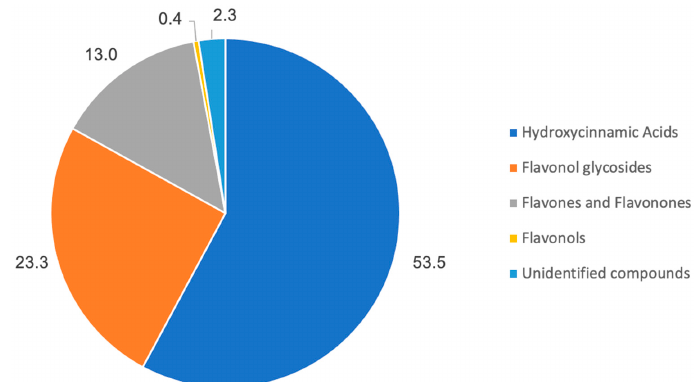
Figure 2. Chromatographic area relative distribution of the principal phenolic functional groups identified in the Summer Savory extract.